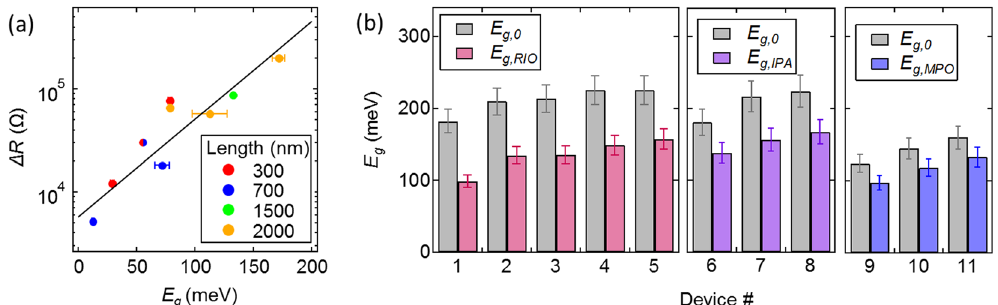
Figure 5. ( a ) Summary of Δ R and E g values for 10 different narrow-gap CNT devices. The source-drain separation distance, L , varies from 300 nm to 2000 nm. ( b ) The transport gap, E g , measured before and after submersion in refractive index oil (RIO), machine pump oil (MPO), and pure isopropanol (IPA). E g is calculated from Eq. 3 using measurements of Δ R . The devices are different from those presented in Fig. 5a, and all have L = 2 μ m, except for device 9 which has L = 1.5 μ m. The estimated experimental error in determination of E g is ±